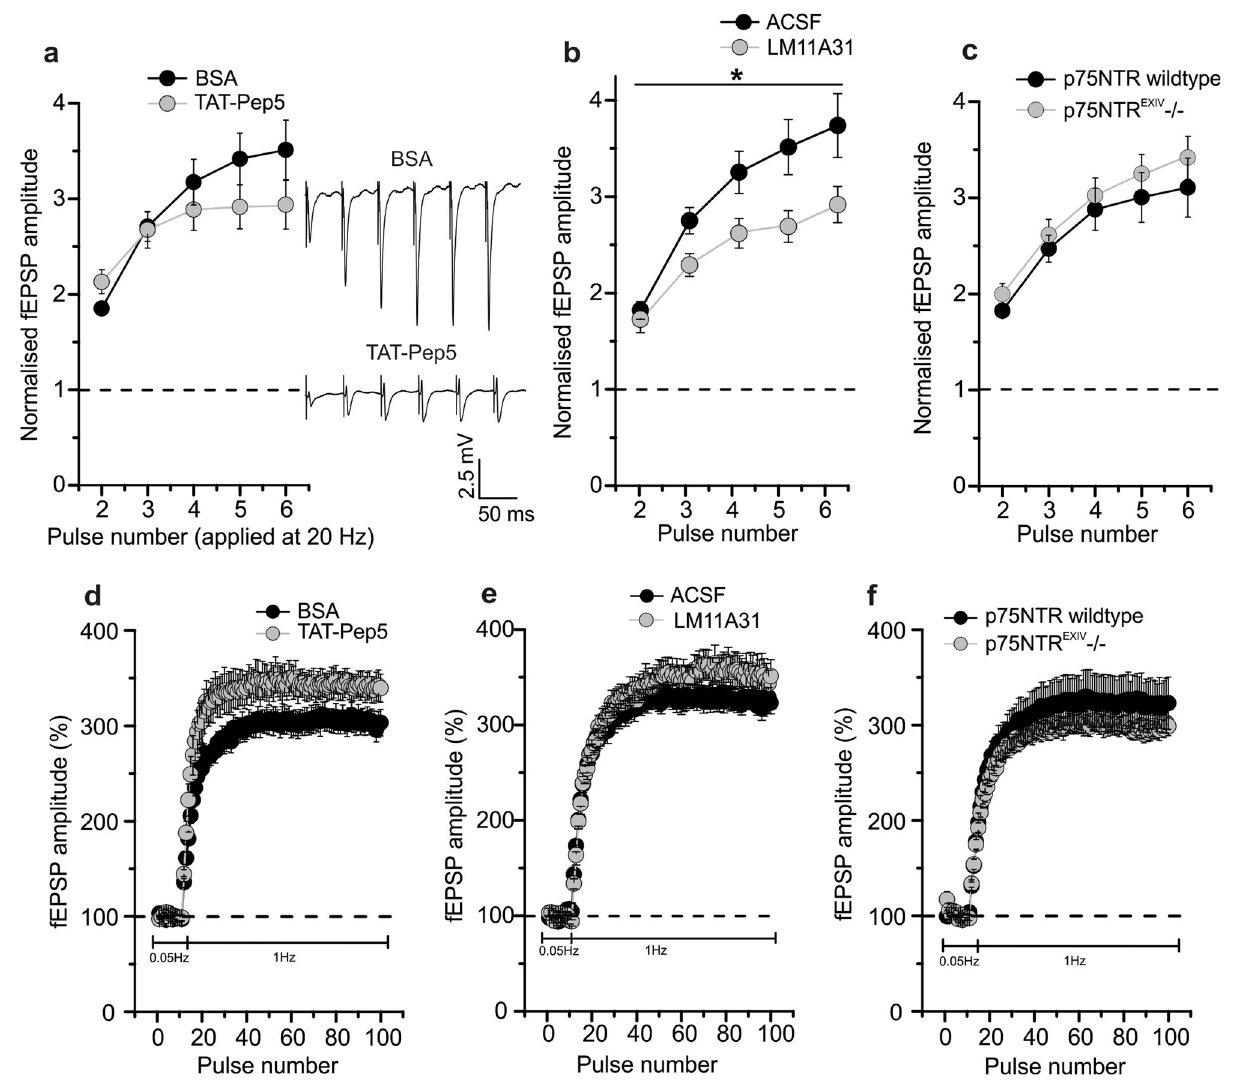
Figure 5. Effect of acute or chronic inhibition of p75NTR signaling on longer lasting short-term synaptic plasticity properties at hippocampal mossy fiber-CA3 synapses. ( a ) and ( b ) extended paired-pulse facilitation paradigm (i.e. train facilitation at 20 Hz) in the presence of bath applied 1 µM TAT-Pep5 ( a ) and 100 nM LM11A31 ( b ) compared to solvent controls. Representative averaged original responses are exhibited for train facilitation in presence of BSA and TAT-Pep5 in the ACSF. Scale bars are displayed in the inset. ( c ) Train facilitation in p75NTR EXIV−/− mice compared to wildtype littermates. ( d ) and ( e ) frequency facilitation at 1 Hz in presence of TAT-Pep5 ( d ) and LM11A31 ( e ). ( f ) Frequency facilitation in p75NTR EXIV−/− mice. Data displayed as mean ± SEM. *p < 0.05 (ANOVA, Mann–Whitney U-test or two-tailed Student’s